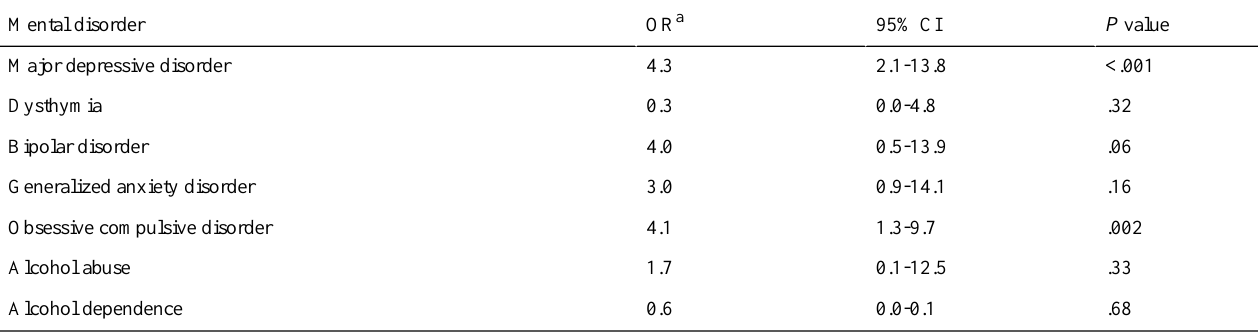
Table 4. Association of online support group use and type of mental disorder in the psychiatric